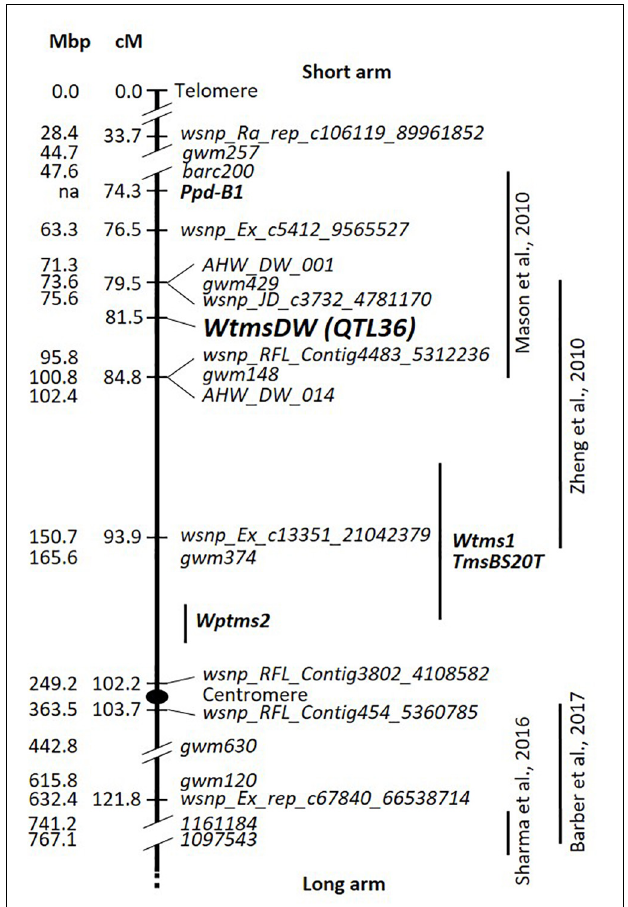
FIGURE 3 | Drysdale × Waagan DH genetic map predominantly for the short arm of wheat chromosome 2B. Mbp locations of markers in the IWGSC v1.0, Chinese Spring reference genome sequence are shown to the left. The centromere position is from Alonge et al. (2020). Positions of temperature-responsive fertility QTL from four other studies are shown on the right. Temperature and/or photoperiod-responsive male-sterility loci Wtms1 , TmsBS20T , and Wptms2 studied for hybrid breeding research are also shown (Xing et al., 2003; Guo et al., 2006a; Ru et al., 2015). Positions of the loci from other studies were located approximately, based on position of markers from the respective studies in the genomic sequence.